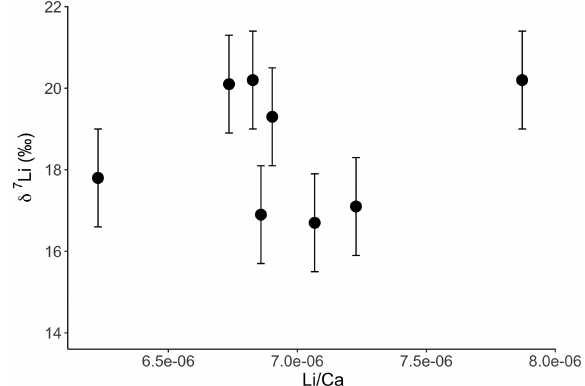
Table A2. Concentrations of lithium in reactive fluids and precipi-